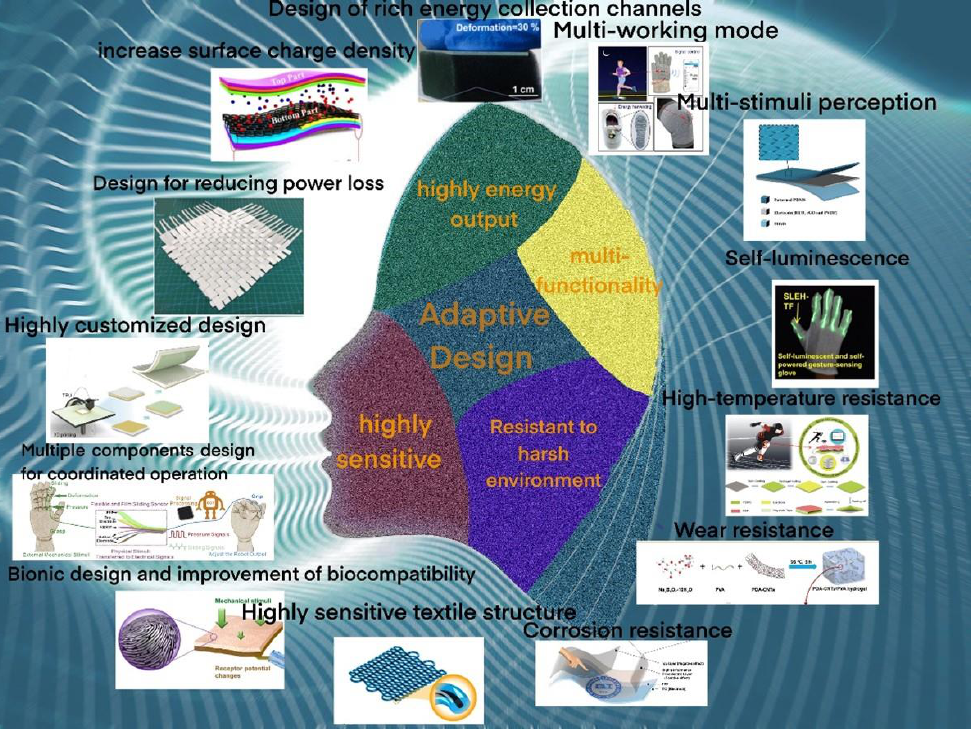
Figure 1. Adaptive design of self-powered systems.